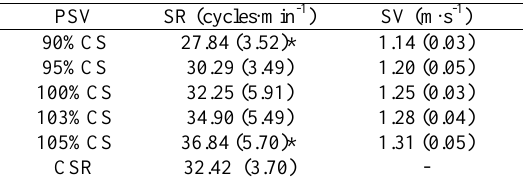
Table 1. Mean and standard-deviation for stroke rate at 200 m (SR and 400 m (SR ), total time for 200 m (Tt 400 critical speed (CS) (n = 10).